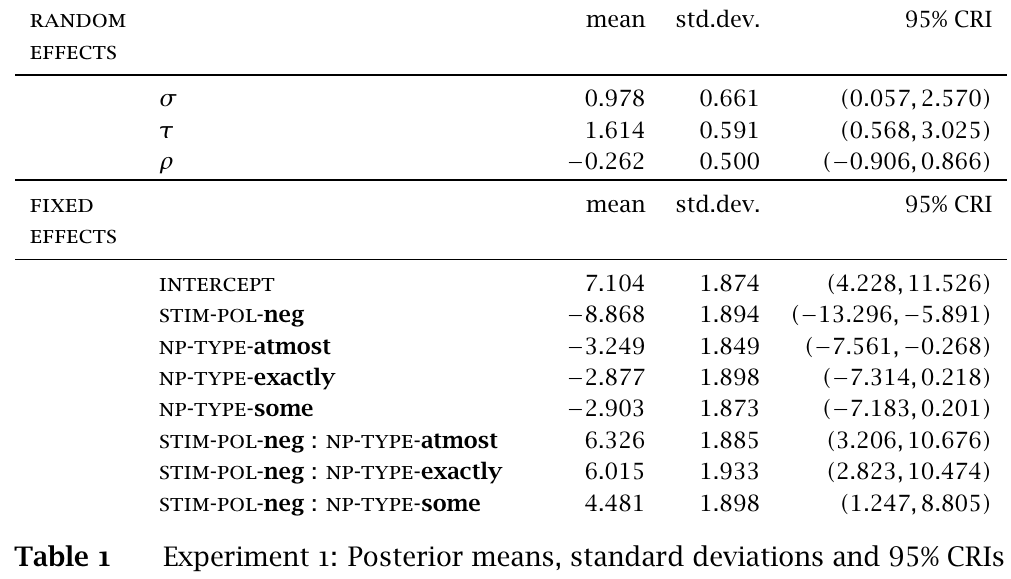
Experiment 1 : Posterior means, standard deviations and 95 % CRIs for the estimated mixed-effects logistic regression